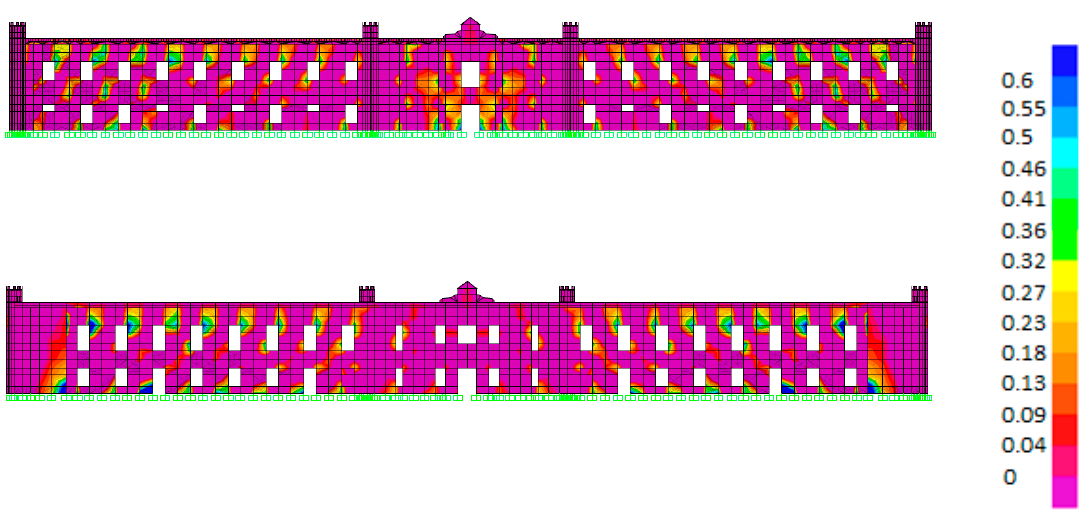
Figure 19. Map of the vertical axial stresses (MPa) from the linear sequential model, front and rear views.